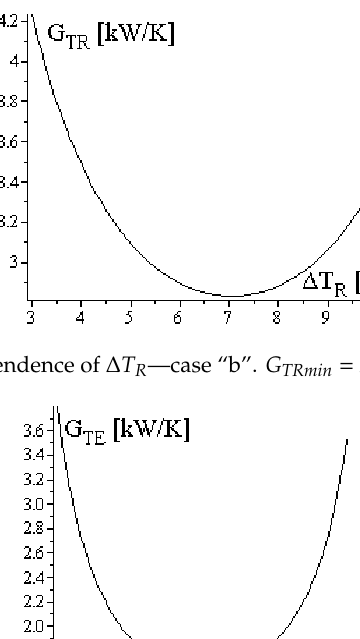
TEmin = 1.296 for Δ TH = 257 K.